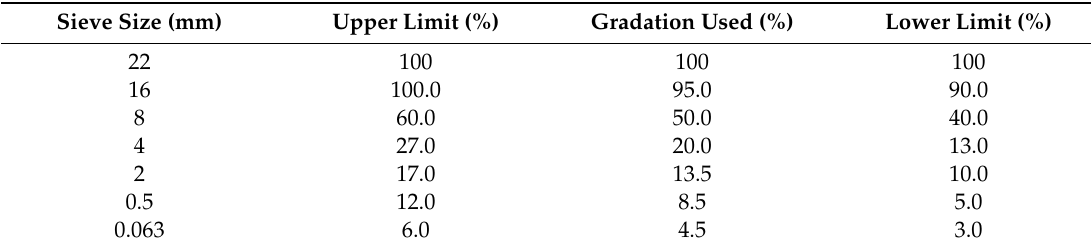
Table 1. Gradation of aggregates used in this research.